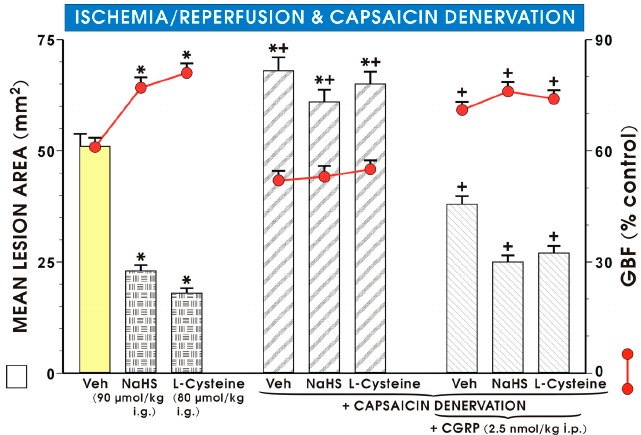
Figure 5. Effect of capsaicin denervation on the mean lesion area and GBF in rats exposed to 30 min of I followed by 3 h of R and pretreated with vehicle, NaHS (90 μ mol/kg i.g.) or L -cysteine (80 μ mol/kg i.g.) alone or in combination with CGRP (2.5 nmol/kg i.p.). Results are mean ± S.E.M of 4–5 rats per each experimental group. Significant change as compared with the respective values in vehicle-control group was indicated by asterisk ( p < 0.05). Asterisks and crosses indicate significant changes compared to the values obtained in the group treated with saline, NaHS or L -cysteine without denervation ( p < 0.05). A cross indicates a significant change as compared with the respective capsaicin-denervated animals without co-treatment with CGRP ( p < 0.05).